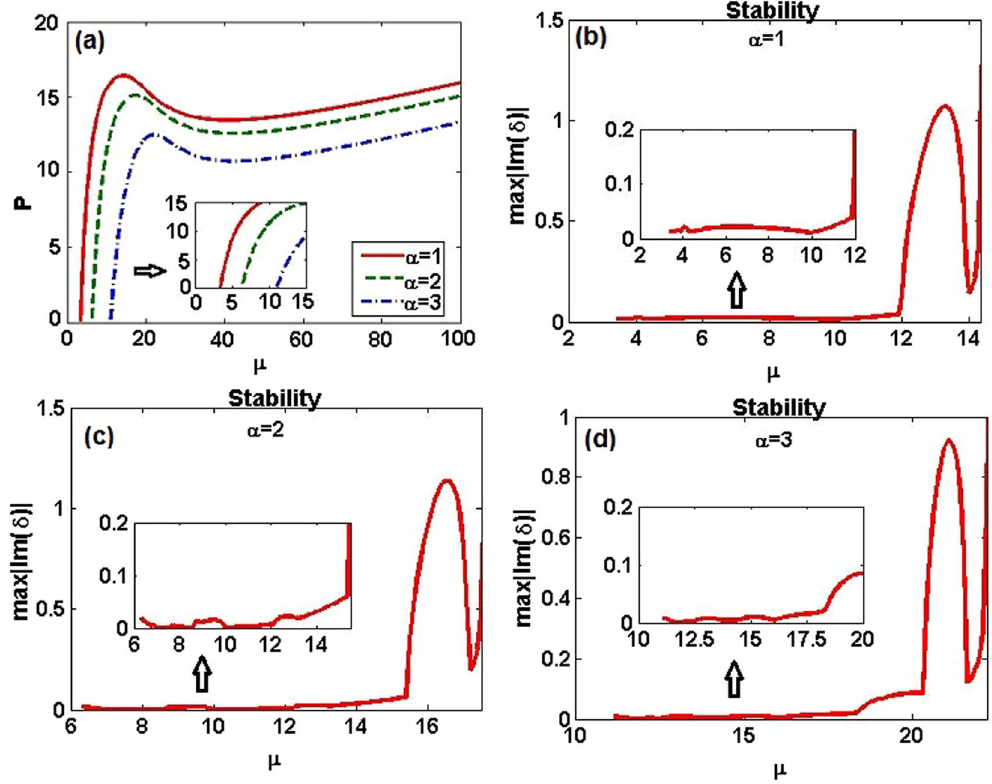
Figure 12. 2D integral power P and linear stability versus the soliton’s propagation constant, − μ . ( a ) Power P versus μ . For the three different cases, α θ = . . . . . . m ( , , ) (1, 0 5, 0 1), (2, 0 4, 0 1), (3, 0 2, 0 1) , there are no upper cutoffs 0 0 of the existence domains for the solitons. The corresponding lower cutoffs are µ µ µ ≈ . ≈ . ≈ . 3 4, 6 3, 11 1 , 1 2 3 respectively. ( b – d ) The linear-stability spectra of numerically found fundamental solitons versus μ , around the corresponding exact nonlinear modes at μ = 9/2, 8, 25/2, respectively. The insets in ( b – d ) clearly show a portion of stability results when μ is located in lower and smaller